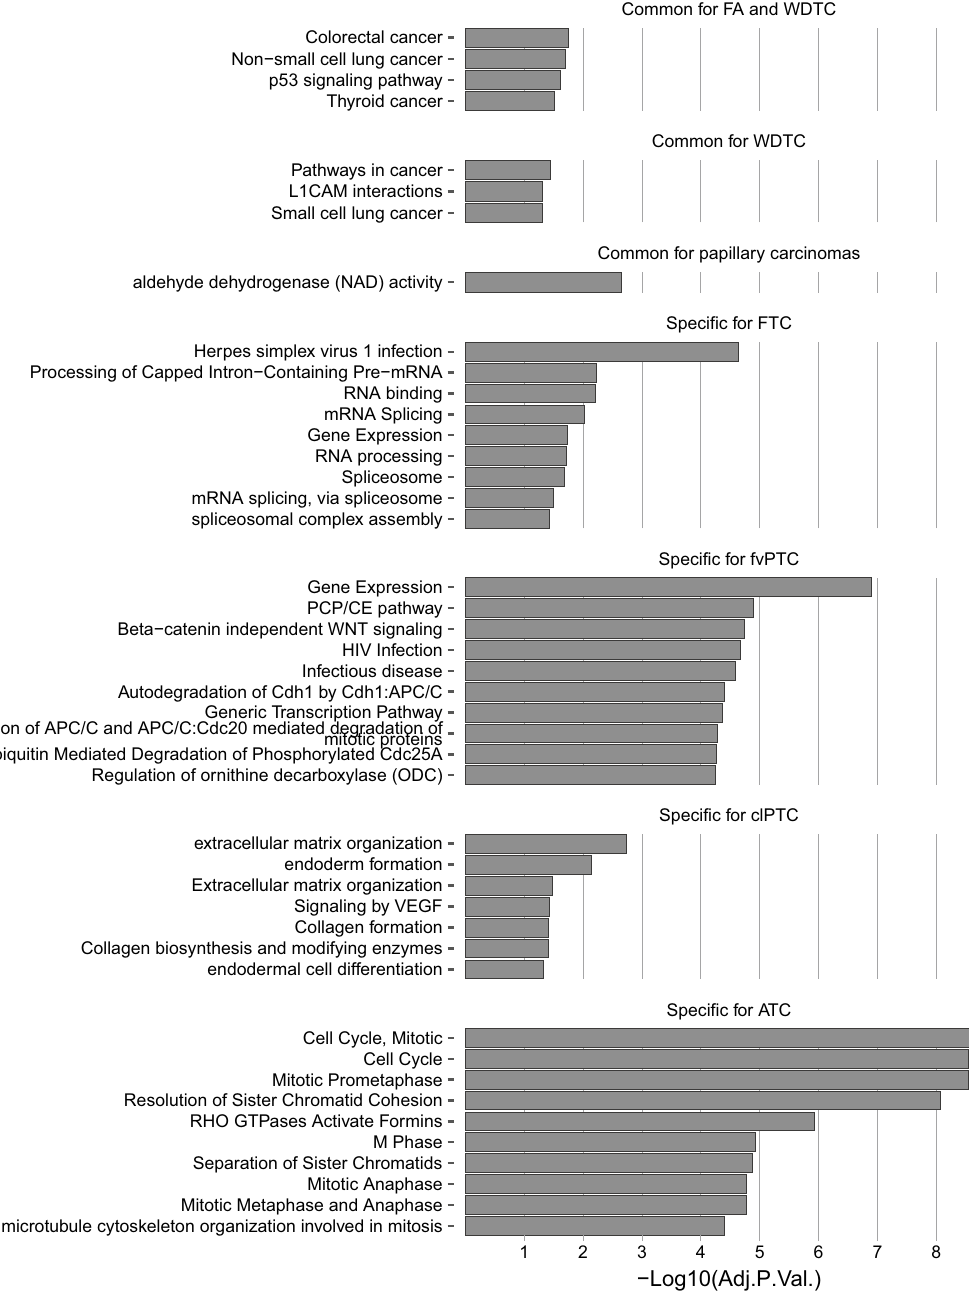
Figure 5. Putative biological process involving aberrantly expressed lncRNAs in thyroid neoplasms. The enrichment analysis of GO Biological Process, GO Molecular Function, KEGG, and Reactome terms was performed for the 5 most differentially expressed lncRNAs, and terms with adjusted p values ≤ 0.05 were considered significantly enriched. For fvPTC and ATC, the 10 most significantly enriched terms are